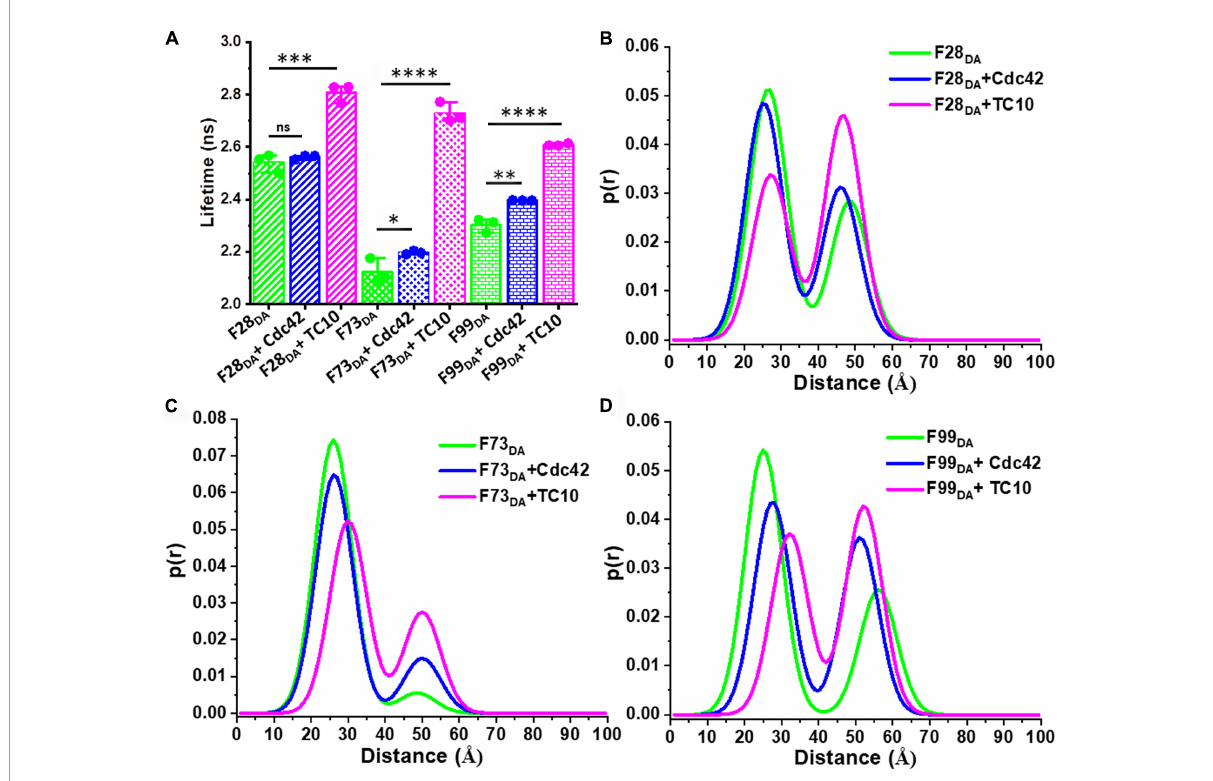
FIGURE5 TC10 and Cdc42 induce varied responses in additional FRET sensors. (A) Bar graph showing the species-weighted average fluorescence-lifetime of F28 DA , F73 DA , and F99 DA alone (green) and in the presence of a 100-fold molar excess of Cdc42 (blue) or TC10 (magenta). ∗ P < 0.05, ∗∗ P < 0.01, ∗∗∗ P < 0.001, ∗∗∗∗ P < 0.0001; ns, statistically not significant. (B–D) Plots showing the distance distribution obtained from the two Gaussian distributed distance fit model for (B) F28 DA , (C) F73 DA , and (D) F99 DA in the absence (green) and presence of Cdc42 (blue) and TC10